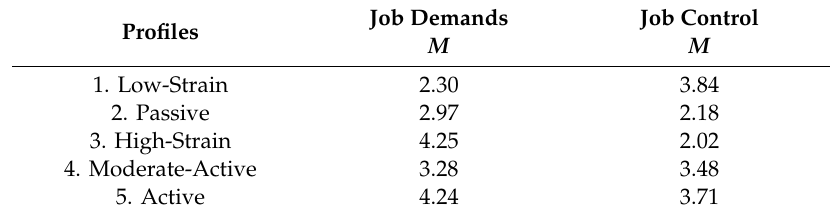
Table 3. Mean values for job demands and job control in each identified profile.